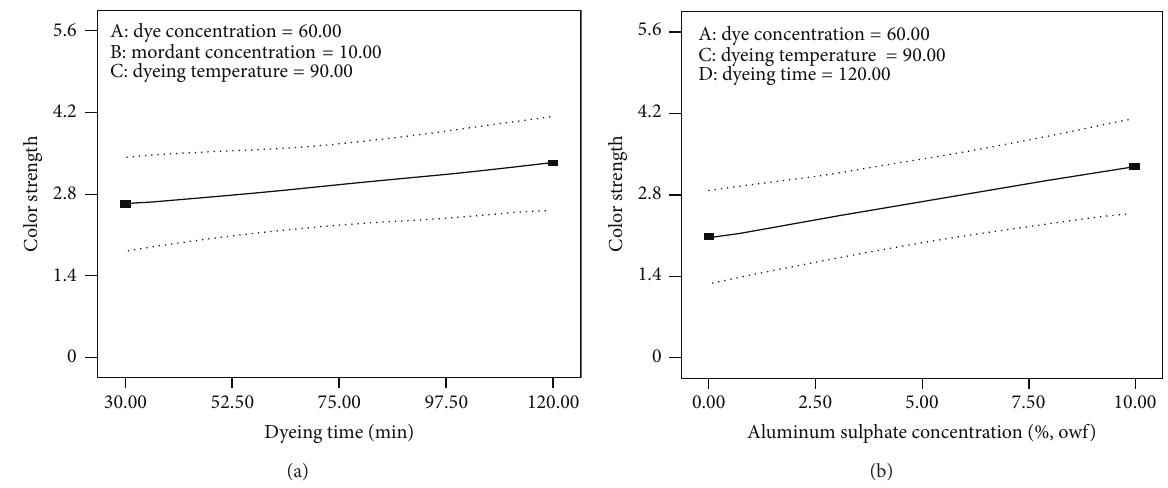
Figure 3: The effect of independent variable dyeing conditions on the color strength of dyed wool fibers with Prangos ferulacea . (a) Dyeing time, and (b) aluminum sulphate concentration (the dotted lines are the confidence bands).